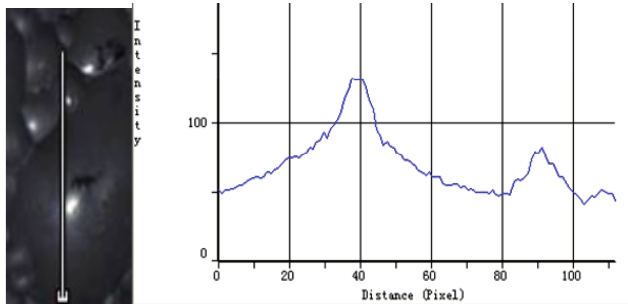
Figure 3. Gray value variation between two bubbles. Left : large bubble and the profile line; Right : the gray value histogram of the profile corresponding to the left image from bottom to